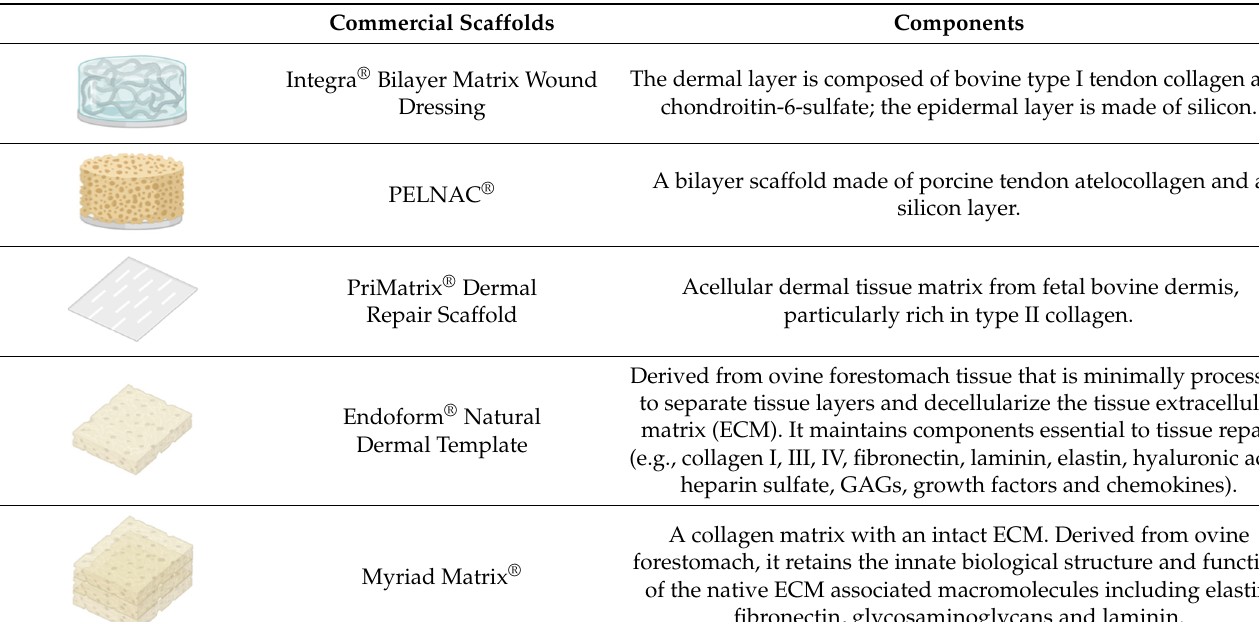
Table 1. Summary of the characteristics of the dermal substitutes analyzed in the current study. Dermal substitute structures were designed using the Blender 3D software (Blender Foundation, Stichting Blender Foundation, Buiklotermeerplein, Amsterdam, the Netherlands).